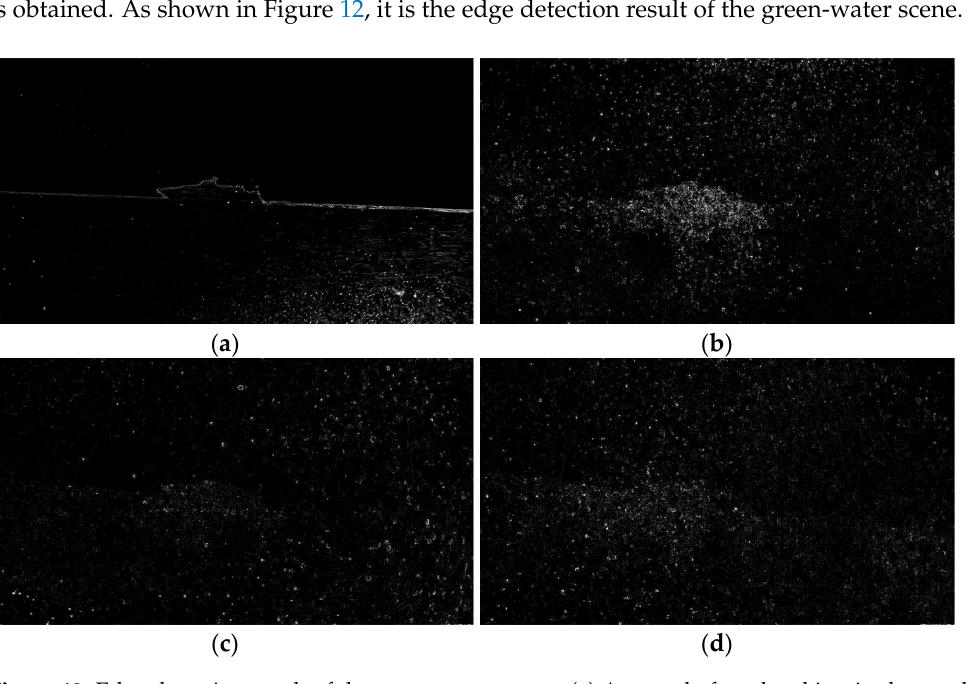
Figure 12. Edge detection result of the green-water scene: ( a ) A scene before the object is obscured; ( b ) The scene 1 where the object is obscured; ( c ) The scene 2 where the object is obscured; ( d ) The scene 3 where the object is obscured.